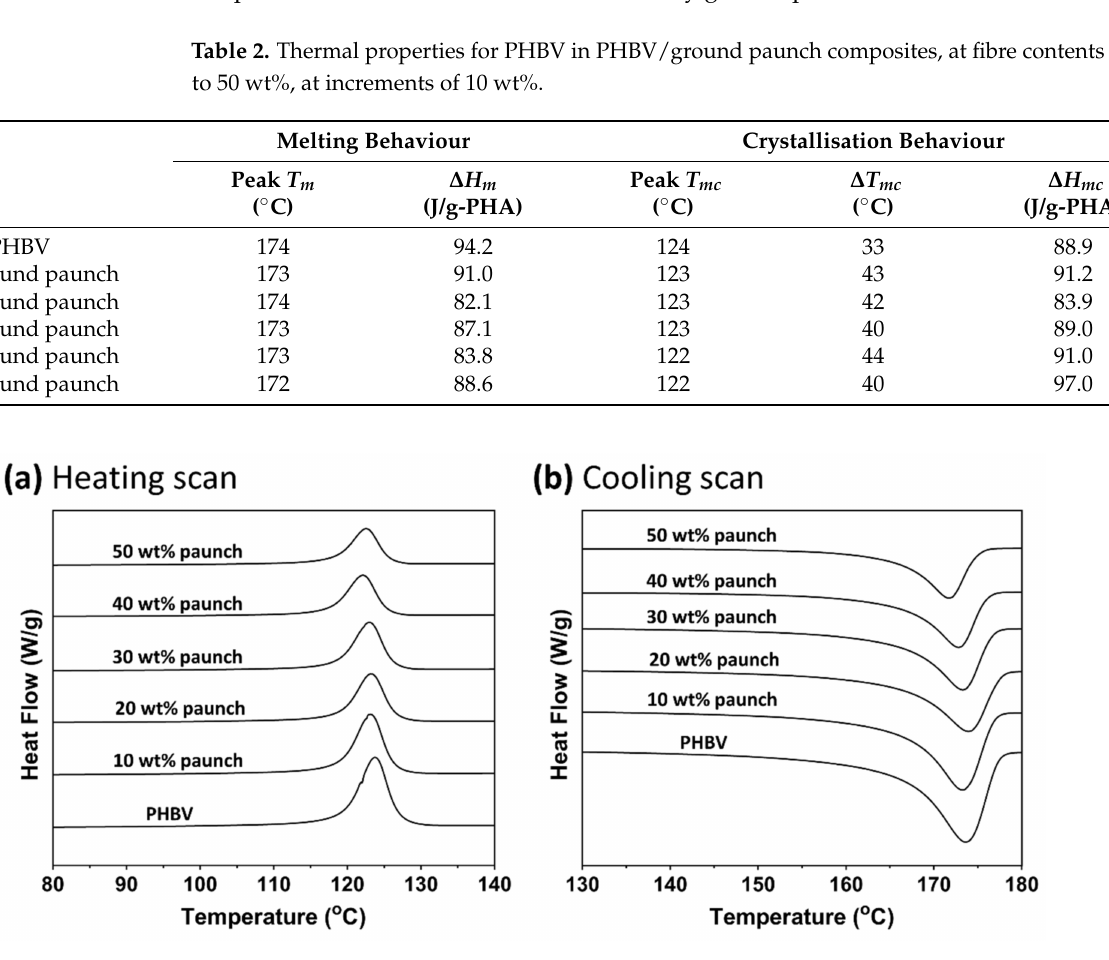
Figure 6. ( a ) First heating scan, and ( b ) first cooling scan from DSC for PHBV in PHBV/ground paunch composites, at fibre contents from 0 to 50 wt%, at increments of 10